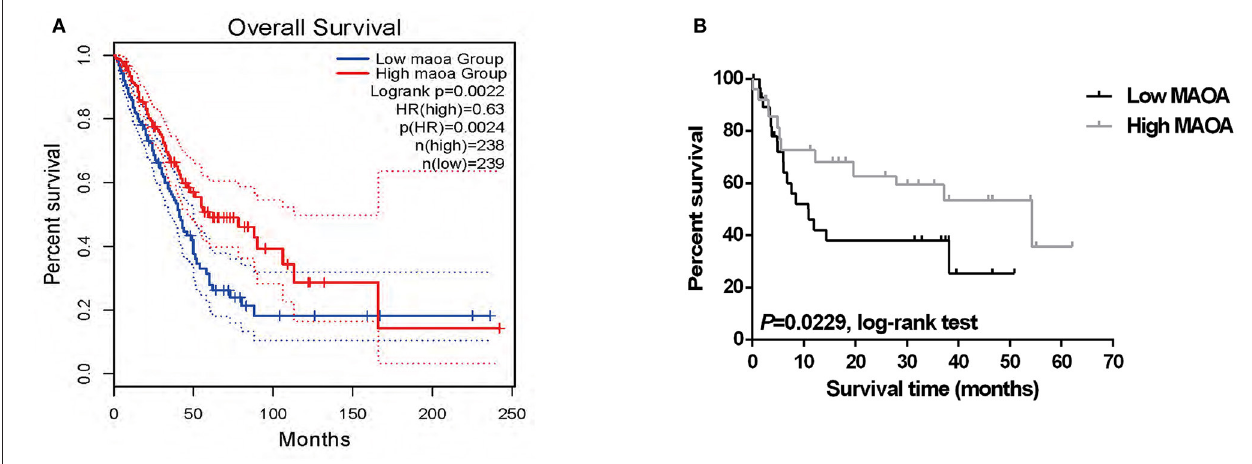
FIGURE 2 | The expression of MAOA correlates with the survival of patients with LUAD. (A) Survival of the patients in two groups according to the median of MAOA mRNA level in GEPIA. (B) The survival of the high MAOA group and low MAOA group analyzed by the Kaplan–Meier analysis.